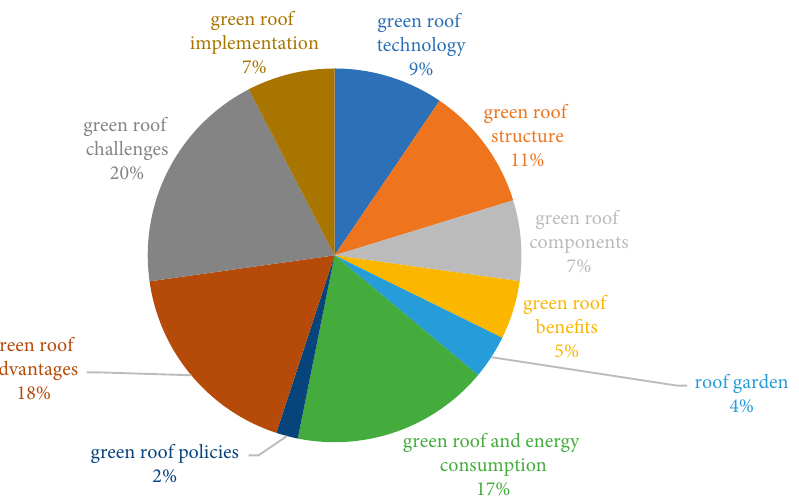
Figure 1: Keywords of some research were used in the current research in green Table 3: The number of articles and research in the field of the green roof by year of publication.